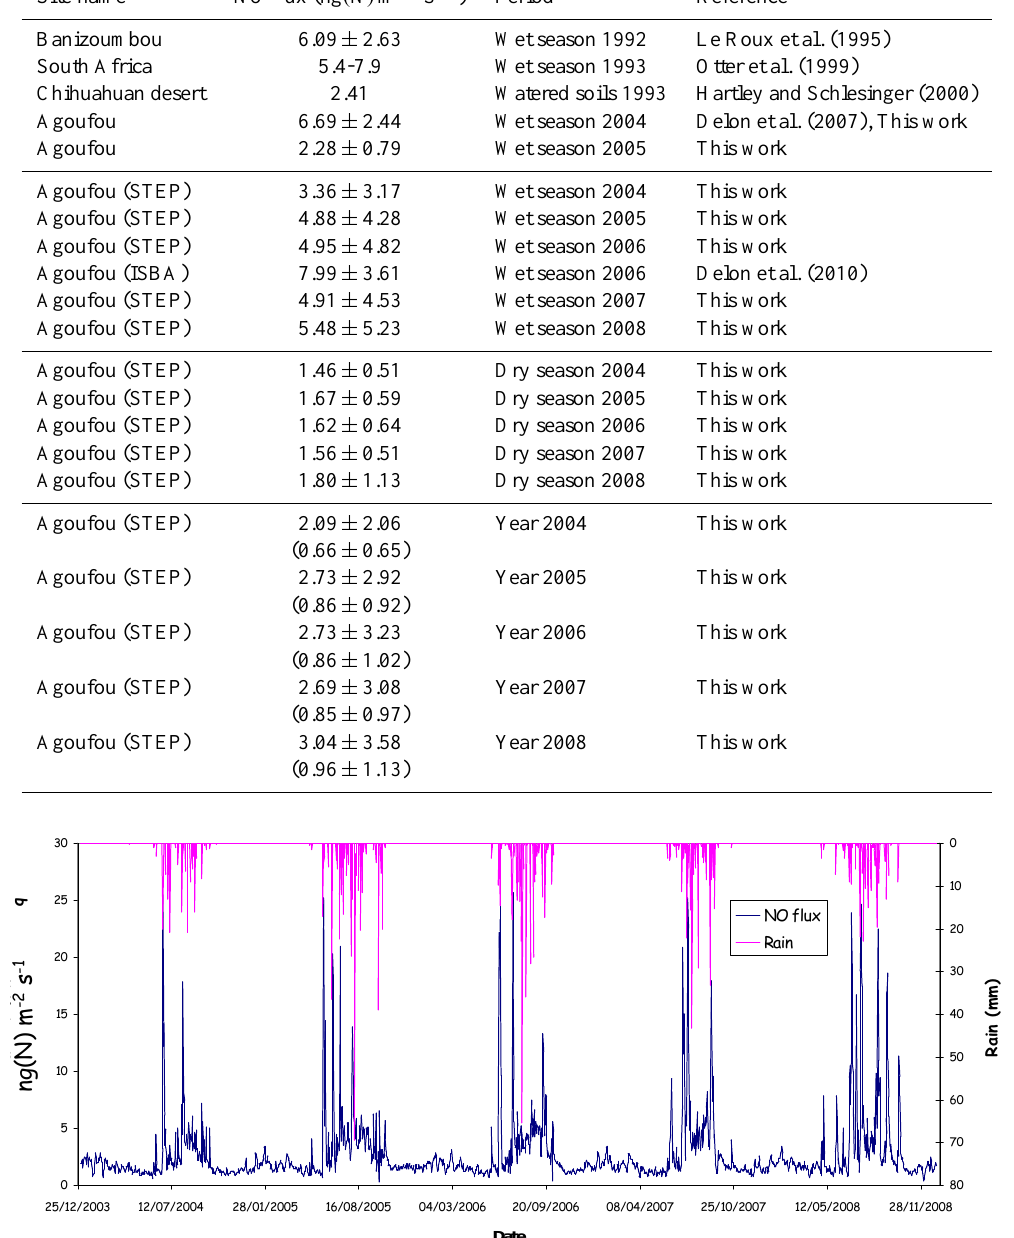
Figure 6. Simulated NO flux in kg ( N ) ha − 1 yr − 1 and rain in mm, for years 2004 to 2008 at